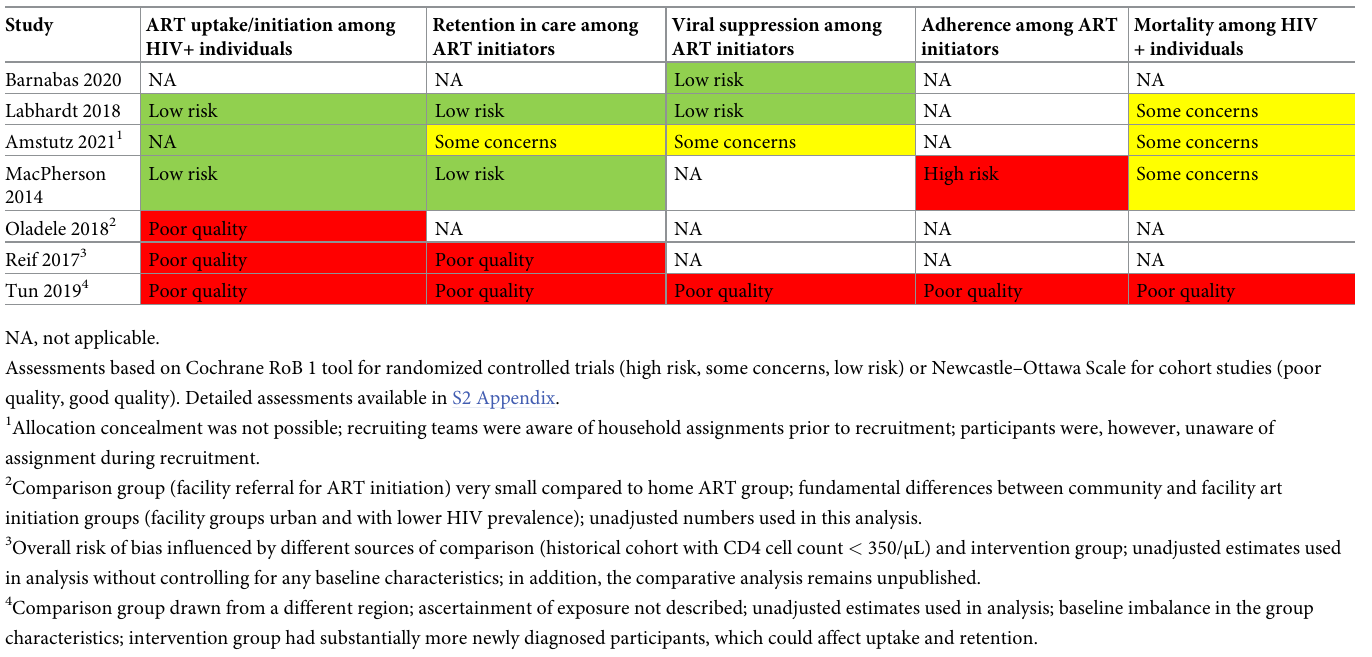
Table 3. Risk of bias